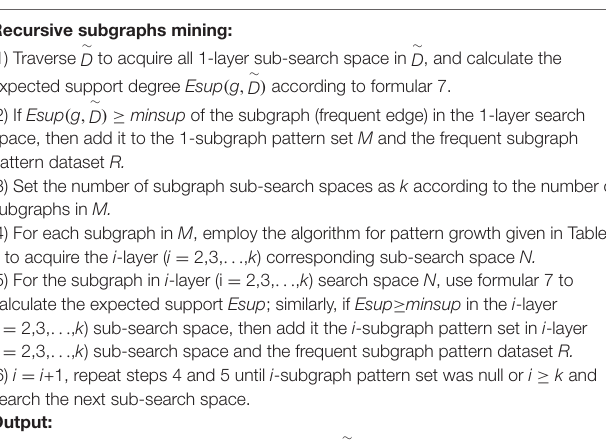
TABLE 2 | Algorithm for frequent subgraph mining based on frequent edges.